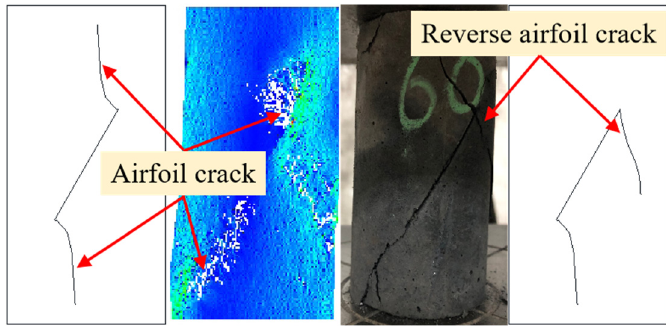
Figure 13. Airfoil cracks and reverse airfoil cracks.